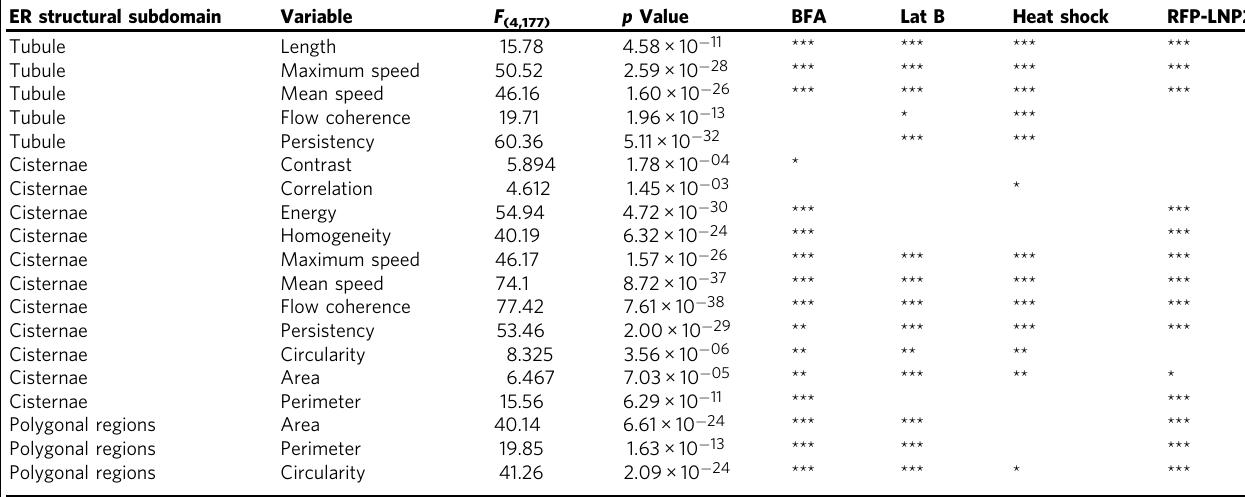
Table 1 ANOVA for a subset of ER variables ER structural